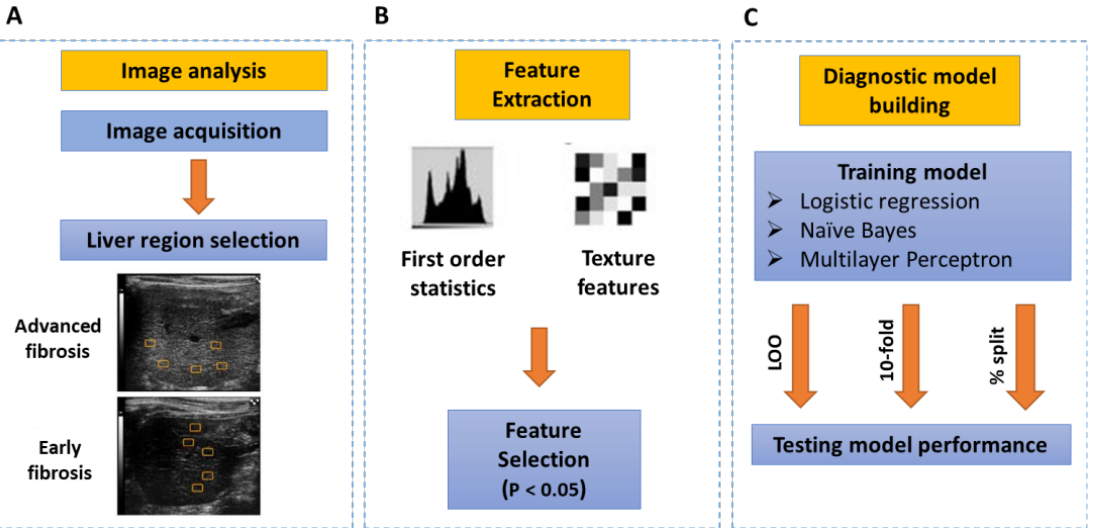
Figure 1. Schematic representation of the image and data analysis process. Subfigure ( A ) shows the image analysis process which includes region of interest ( ROI) placement on the selected liver images. Subfigure ( B ) shows the feature extraction from the selected liver ROIs. Features extracted include: first order statistics and computerized texture features. These features are then further selected by t-test, for building the predcitive model. Subfigure ( C ) demsontrate the different steps towards building the predtive diagnostic model, consisting of: training the data set by different classfiers and with different data spitting methods, then applying these methods for testing the diagnostic performance of data.